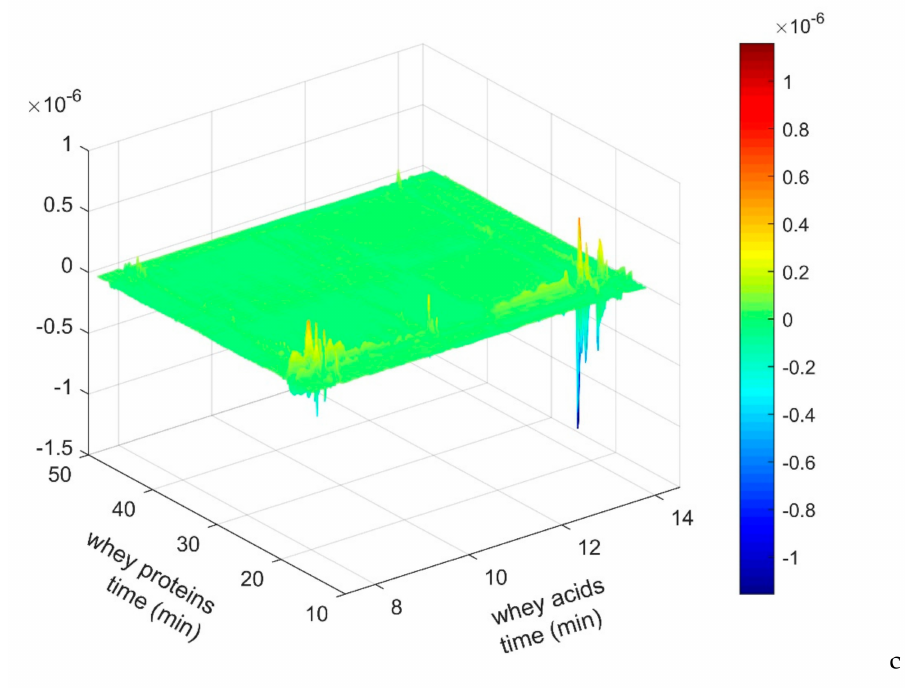
Figure 4. Hetero analysis correlation maps: RPC vs OA content. ( a ) Grana type cheese; ( b ) Crescenza lab test; ( c ) Crescenza pilot